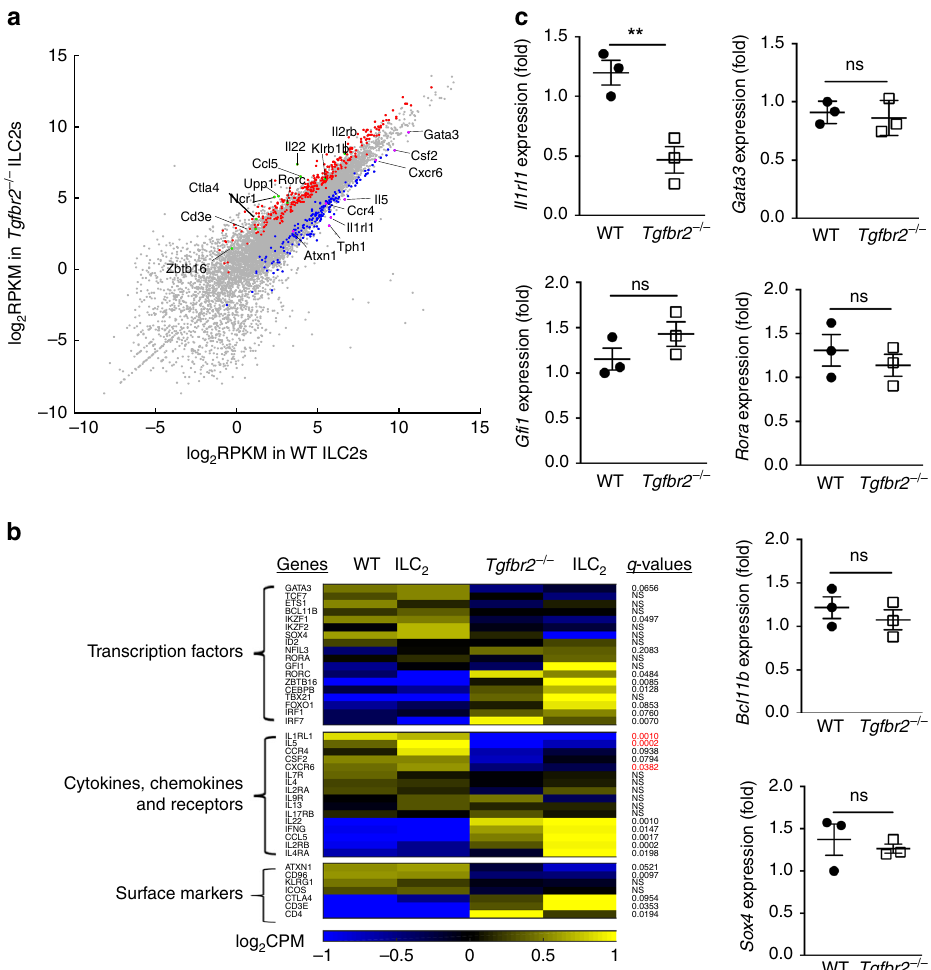
Fig. 3 TGF- β signaling sustains expression of genes critical for the ILC2 program. a RNA-seq analysis of sorted ILC2 (CD45.2 + Lin − Sca1 + CD25 + KLRG1 + ) in the LP of tamoxifen- ( Tgfbr2 − / − ) or oil-treated (Control) Tgfbr2 f/f ER-Cre + mice. Data are shown as a scatter plot of log2 of FPKM (fragments per kilo base of transcript per million mapped reads) from Tgfbr2 − / − and WT ILC2s. Blue dots represent downregulated genes, and red dots represent upregulated genes in Tgfbr2 − / − ILC2s. Genes of interest are indicated and marked in purple (downregulated) and green (upregulated). b Heat map of the expression of select genes (left margin) in WT and Tgfbr2 − / − ILC2s, grouped according to the function of their products (left margin). NS, not signi fi cant ( q value, ≥ 0.2) (Student ’ s t -test, Benjamini and Hochberg correction for multiple tests). c Quantitative RT-PCR analysis of the indicated genes mRNAs expressed in the puri fi ed Tgfbr2 − / − and WT ILC2s in LP. Data shown are combined data of three independent experiments and are presented as mean ± SEM (** p < 0.01, ns, no signi fi